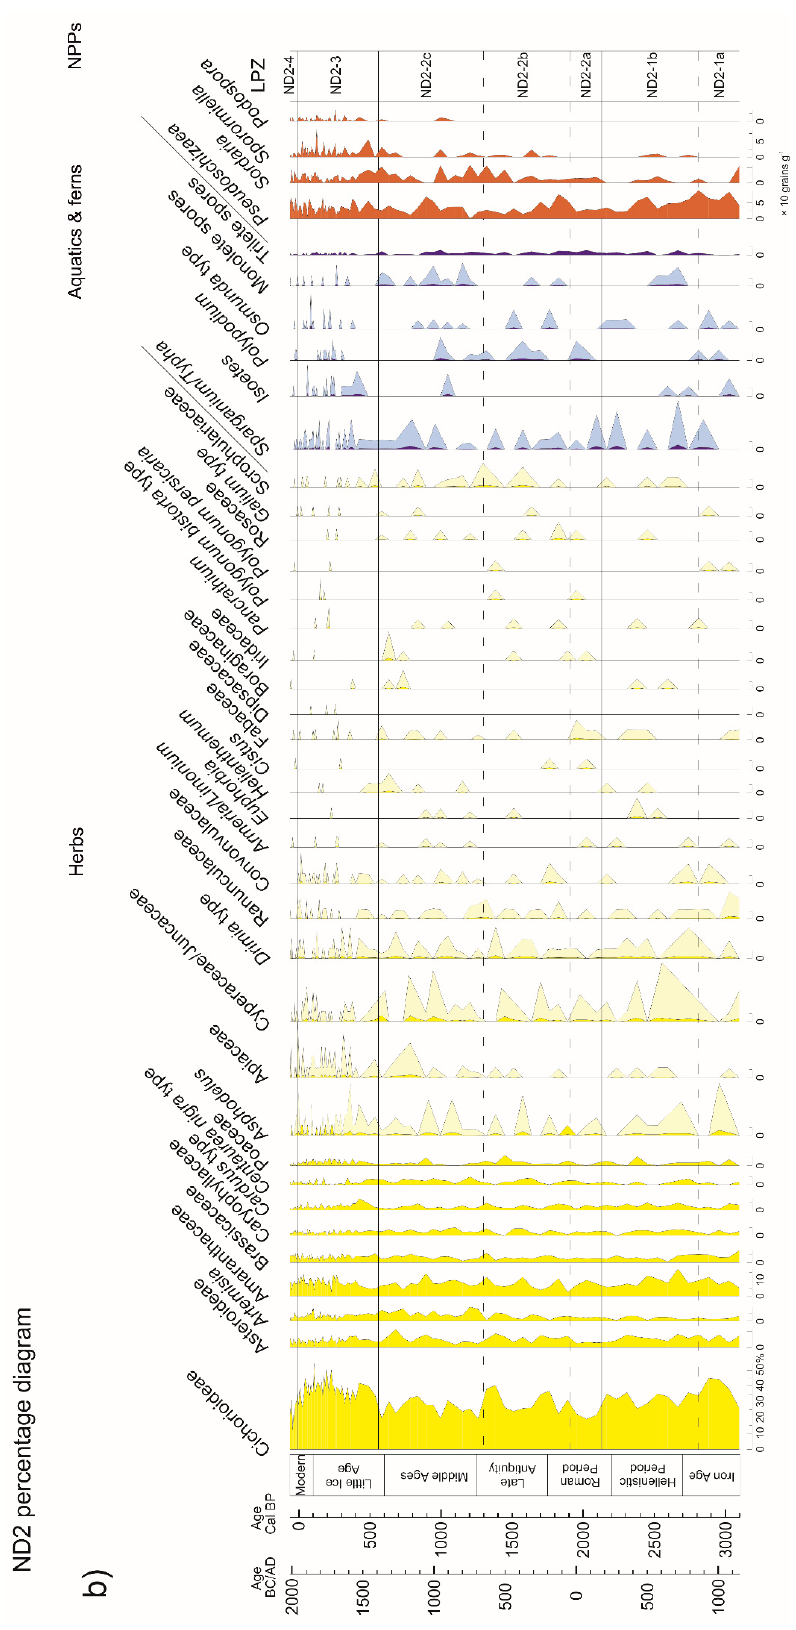
Figure 3. Pollen percentage diagram of selected taxa from core ND2 ( × 10 exaggeration in pale color). Pollen percentages of arboreal taxa ( a ). Pollen percentages of herbaceous taxa and NPP concentration ( b ). The complete pollen record is reported in Figure